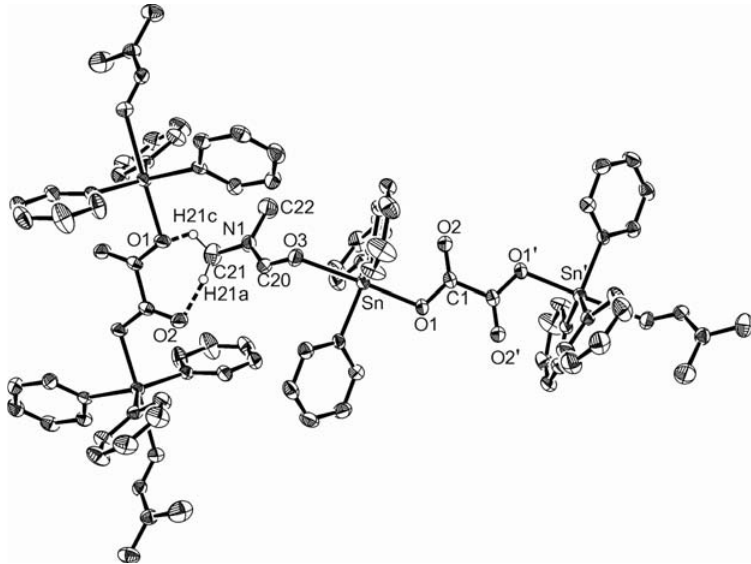
Figure 1 Schematic structural view of the title